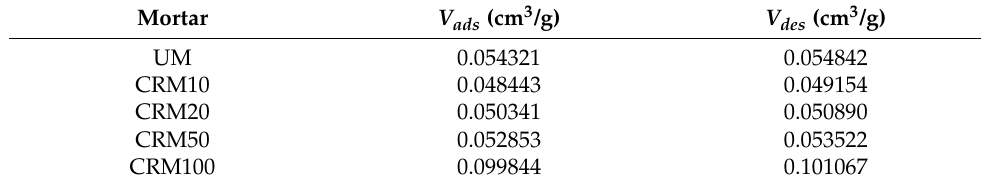
Table 5. Porosity measured in pore volume (N 2 adsorption and desorption phases).